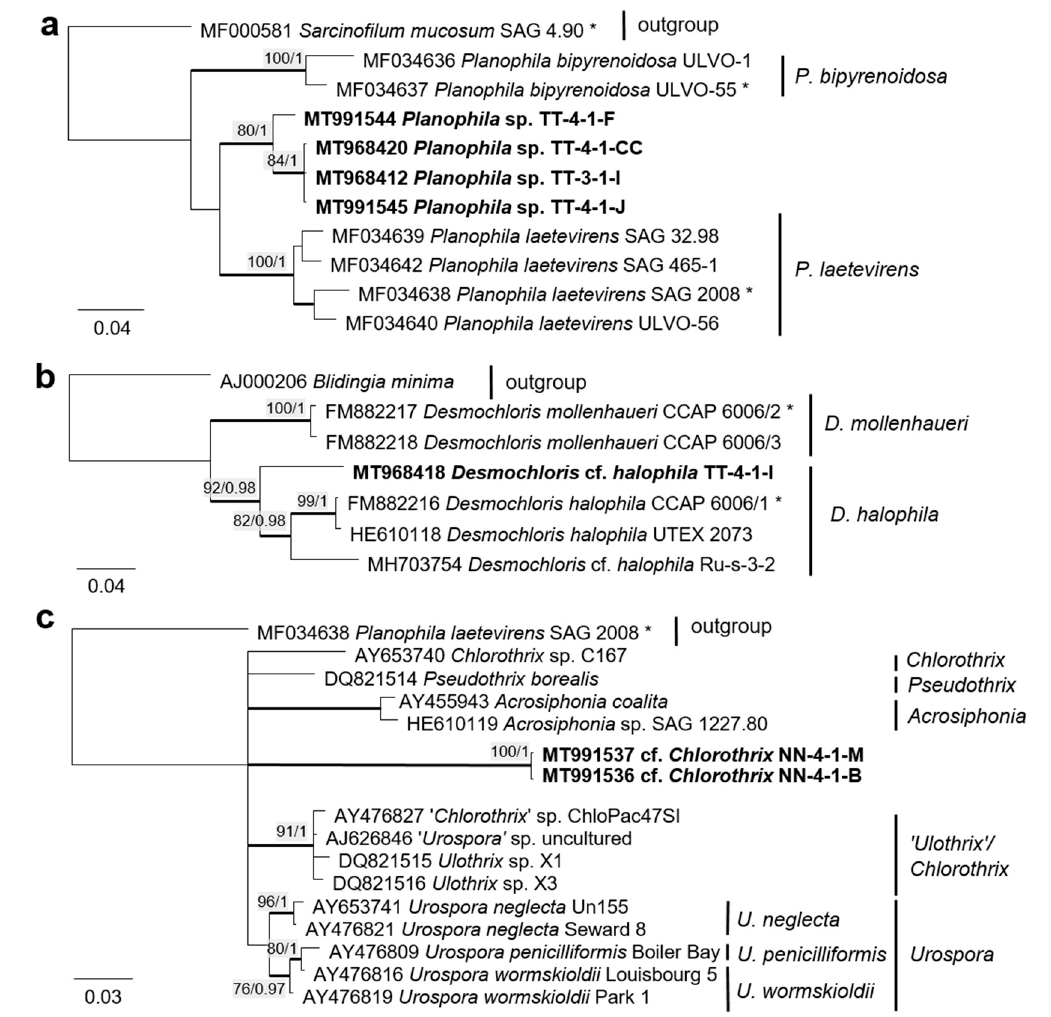
Figure 10. Molecular phylogeny of selected genera of the Ulvophyceae based on ITS-1,2 sequencing. ( a ) Planophila , ( b ) Desmochloris , and ( c ) Acrosiphonia -clade. The phylogenetic tree was calculated by the Bayesian method, including posterior probabilities (PP) with additional maximum likelihood bootstrap values (BP); branches are supported by both methods in bold (BP > 60% and PP > 0.9). Authentic strains marked with an asterisk, original strains from this study in bold.